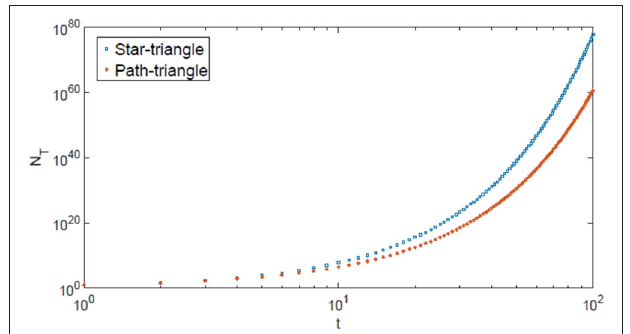
FIGURE 6 | Log-log plot of η ( P △ t ) and η ( S △ t ) vs. t .